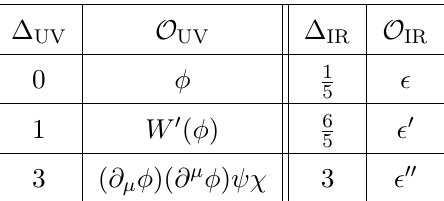
Table 1 . UV to IR matching of scalar Virasoro-primary operators in the flow from the free theory to the critical point of